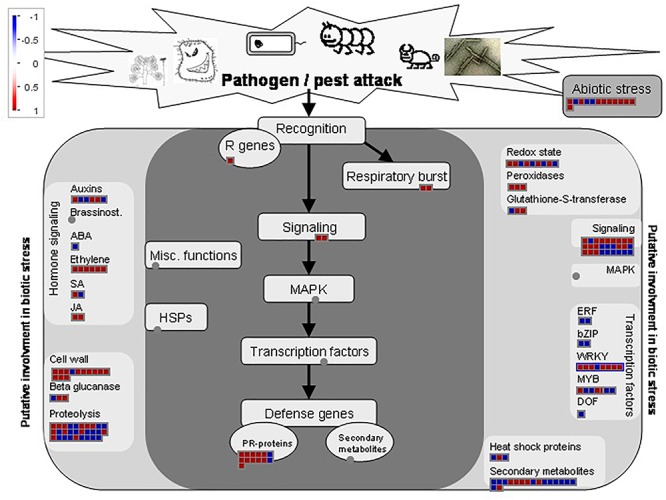
Biotic stress overview pathway for BG11-inoculated plants DEGs as generated by MapMan software. Red and blue boxes represent up and downregulated genes, respectively. Colour intensity represents the degree of expression given as log2 fold change >1 and <–1.